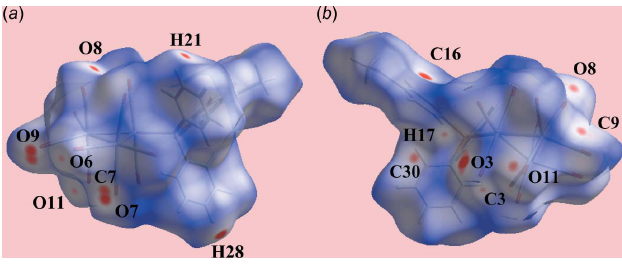
Figure 3 Two views of the Hirshfeld surface of (I) mapped over d norm in the range (cid:5) 0.106 to +1.524 au.